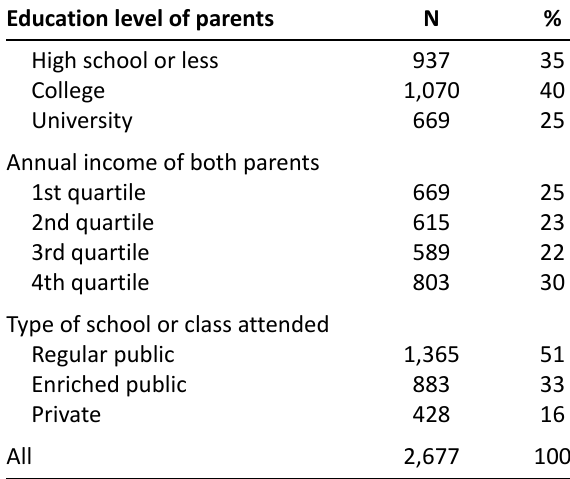
Table 1. Distribution of respondents by social origin and type of secondary school